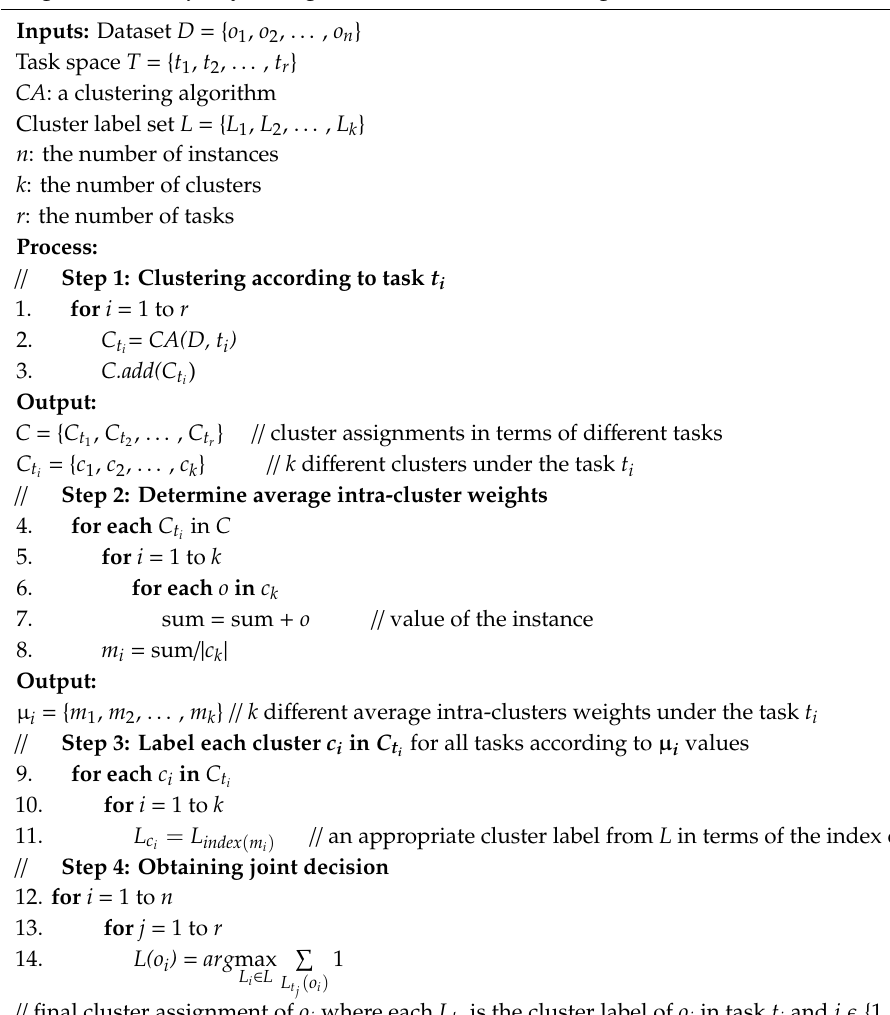
Algorithm 1: Majority Voting based Multi-task Clustering